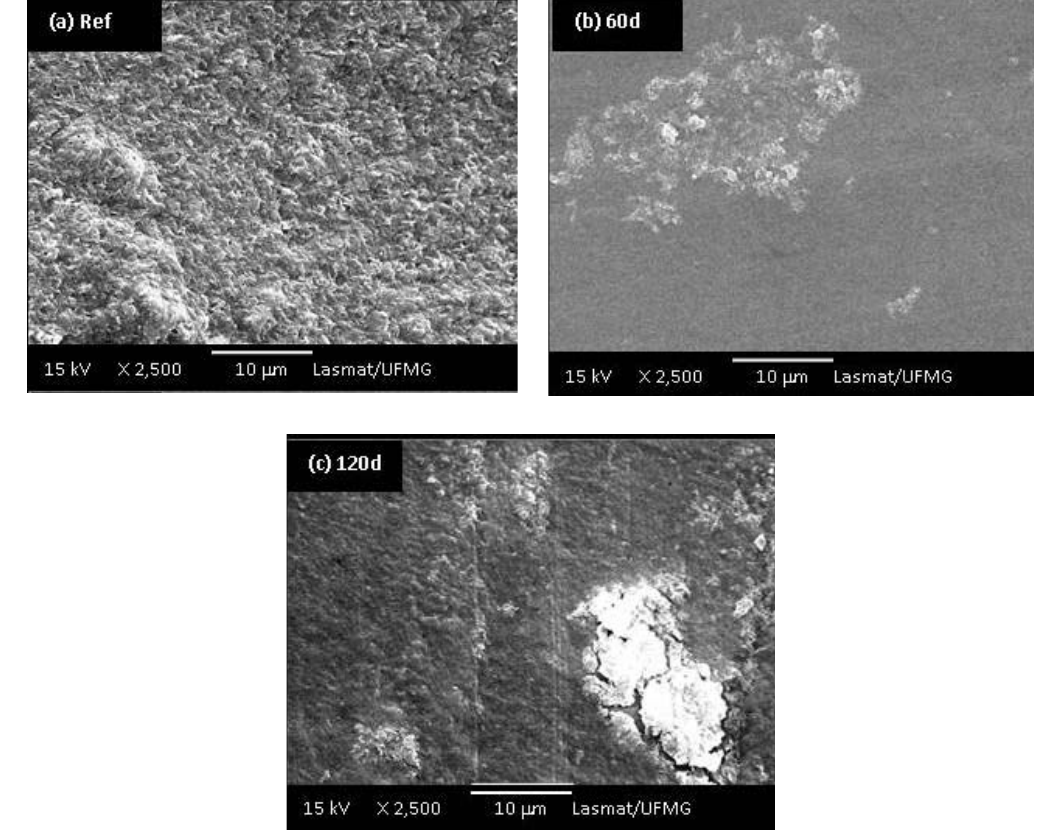
Figure 9. (a) SEM images of UHMWPE reference sample; UHMWPE oxidized with H for (b) 60 days and (c) 120 days (at 2,500 X